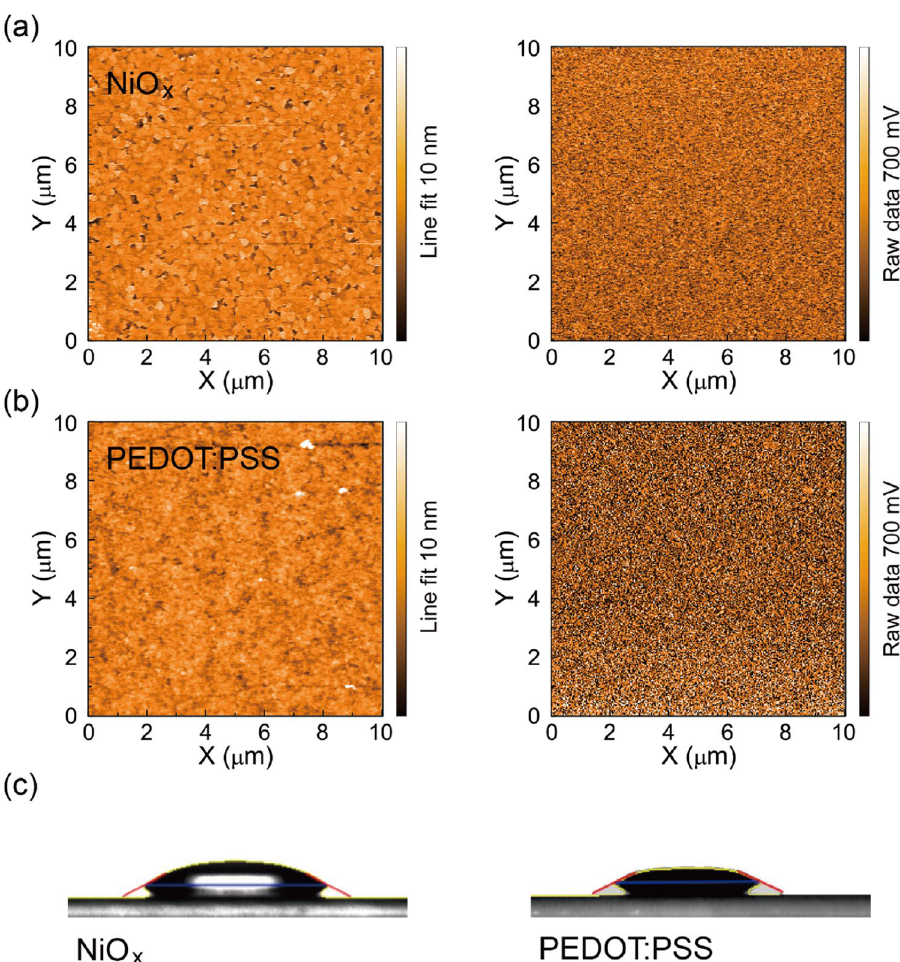
Figure 1. AFM (left) and KPFM (right) images of a sample NiO x layer ( a ) and a reference PEDOT:PSS layer ( b ), and ( c ) water contact angles of the NiO x (left) and PEDOT:PSS (right)